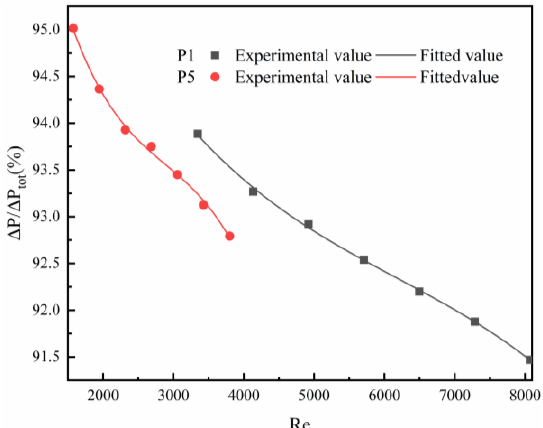
Figure 7. Ratio of pressure drop in the long micro-tubes to the total pressure drop.